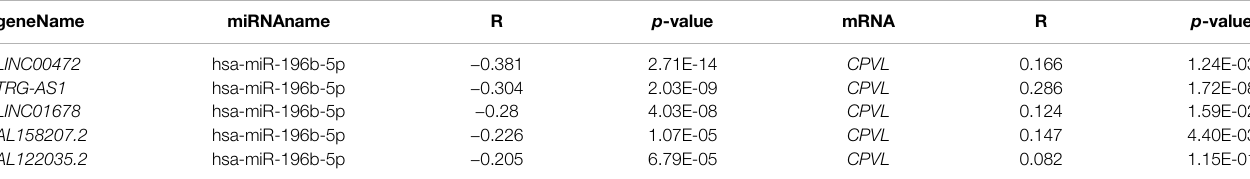
TABLE 3 | Correlation analysis between lncRNA and hsa-miR-196b-5p or lncRNA and CPVL in GC determined by starBase